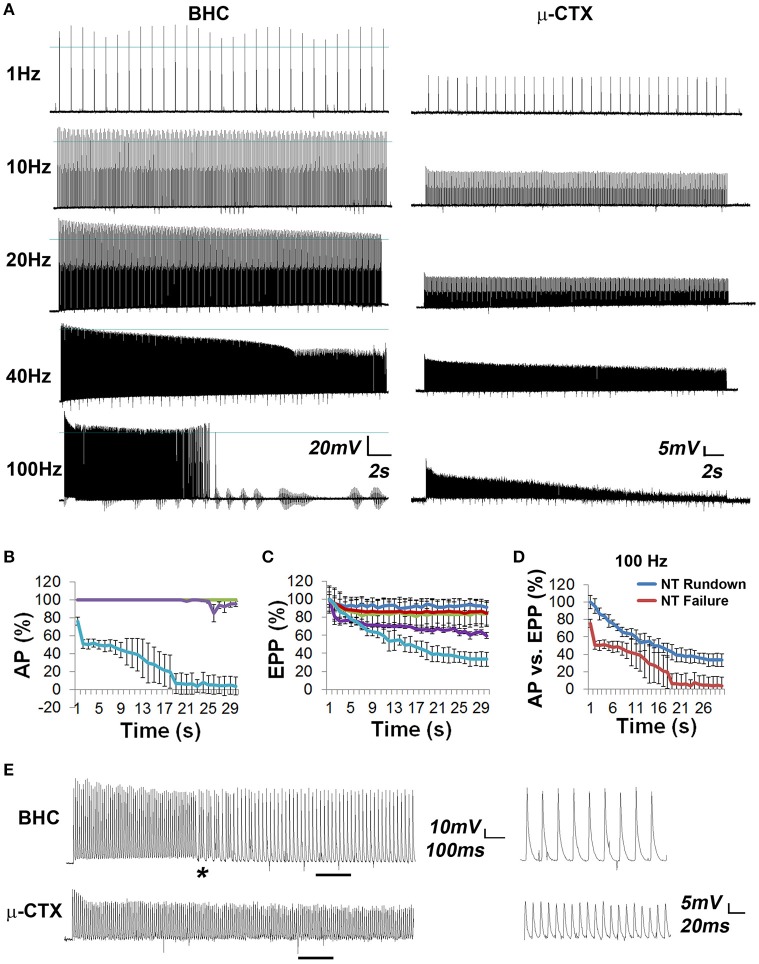
Comparison of EPPs vs. muscle APs in whole diaphragm in response to high-frequency nerve stimulation (HFS) shows that muscle APs fail intermittently, whereas neurotransmitter release falls gradually. (A) Left panels show representative muscle AP traces, recorded in the presence of 50 μM BHC, in response to 30-s trains of tonic phrenic nerve stimulation at different frequencies. Overshoots are portions of the muscle AP above 0 mV, which is demarcated by a blue line in each trace. Right panels show representative EPP traces, recorded in the presence of 2.3 μM μ-CTX, in response to the same stimuli. Note the presence of muscle AP failure in response to 100 Hz. (B) The percent of successfully transmitted muscle APs per second (AP %), over time, in response to different frequencies of HFS (blue = 1 Hz; red = 10 Hz; green = 20 Hz; purple = 40 Hz; light blue = 100 Hz. The straight line at 100% for 1, 10, and 20 Hz reflects the lack of failure in response to 30 s of stimulation at these frequencies. (C) Synaptic rundown of released neurotransmitter (NT), measured by EPP amplitude, in response to the same trains of stimuli. (D) Comparison of NT release rundown (in presence of μ-CTX) and neural transmission failure (NTF) in presence of BHC. (E) Left panel shows a comparison of the first few seconds of AP (BHC) and EPP (μ-CTX) traces in response to 100 Hz stimulation. Asterisk represents first failed AP. Underlined areas are enlarged in right panel and show the pattern of APs and EPPs after a corresponding period of HFS. For every muscle AP, there are two, nearly equal-sized EPPs.